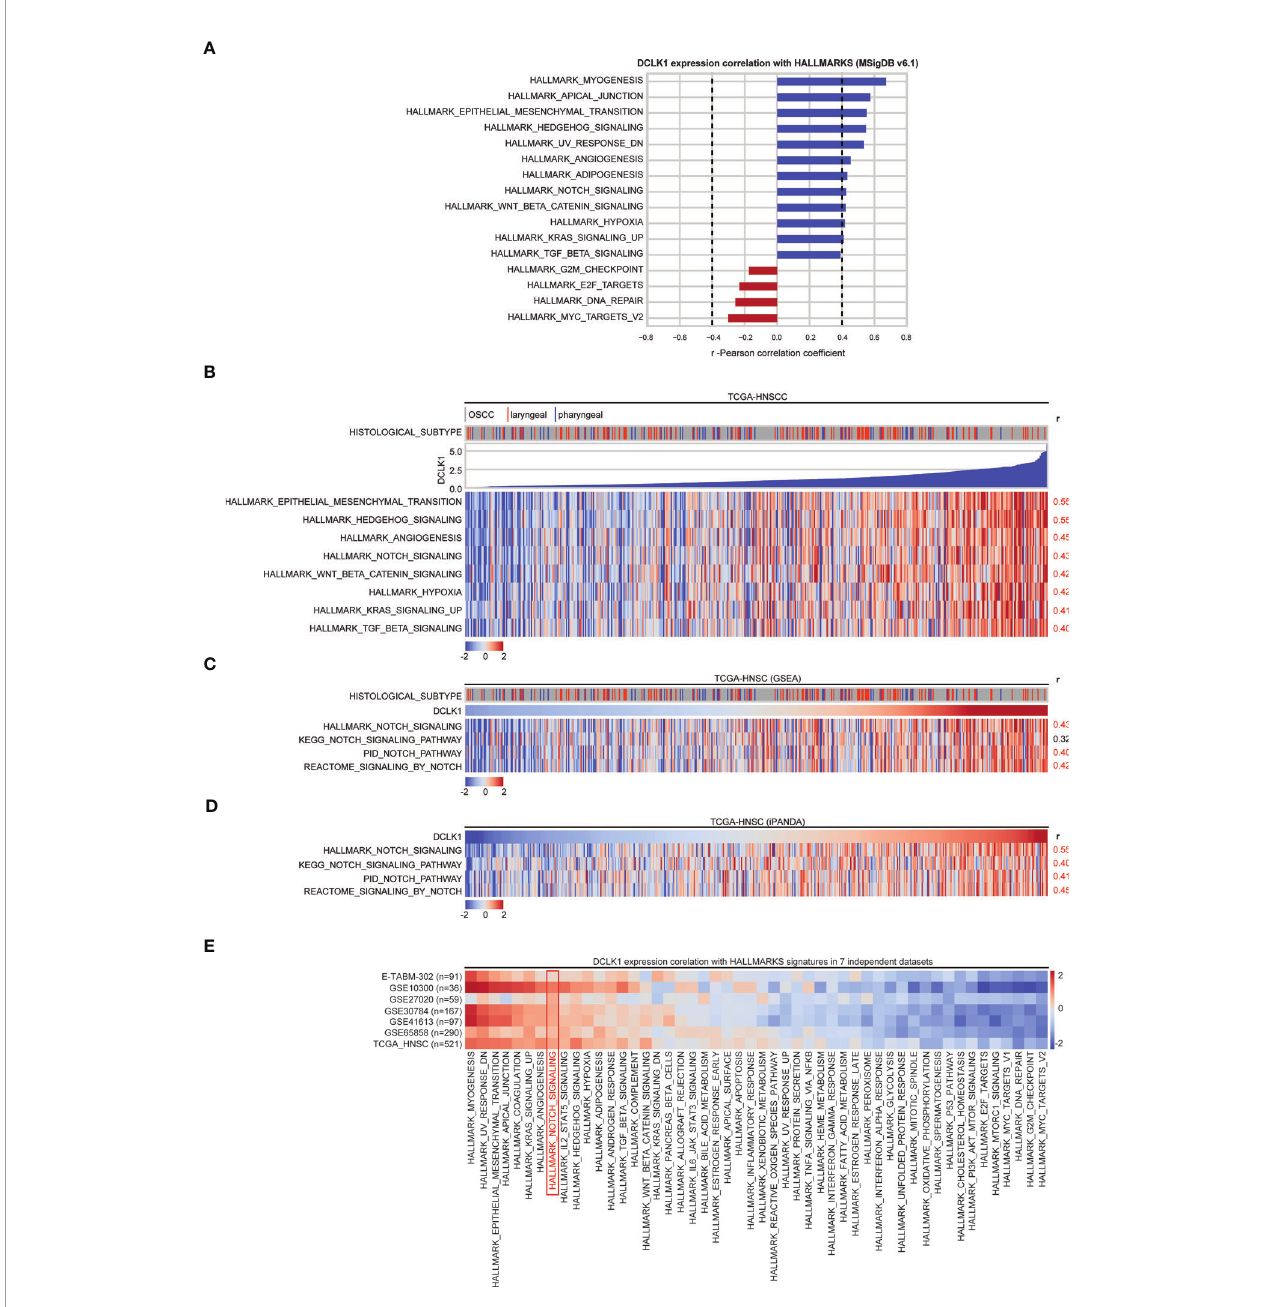
FIGURE 4 | DCLK1 correlates with NOTCH pathways in HNSCC tumors. (A) GSEA results of MSigDB Hallmark of cancer gene sets that correlate with DCLK1 mRNA expression in TCGA-HNSC transcriptomic dataset. Blue bars indicate a positive correlation with DCLK1 mRNA expression, whilst red bars indicate negative correlations. Dashed lines indicate Pearson correlation coef fi cient thresholds for inclusion of the pathways for further analysis. (B) Heatmap demonstrates Hallmark pathways that positively correlate (r > 0.4) with DCLK1 mRNA expression in TCGA-HNSC transcriptomic dataset. (C) GSEA was performed using NOTCH signaling axis genes derived from 4 pathway databases: KEGG, Reactome, PID, and Hallmark. A positive correlation between DCLK1 mRNA expression and estimated NOTCH signaling enrichment using each database is indicated by r-values on the right. (D) iPANDA software suite for analysis of intracellular signaling pathway activation based on transcriptomic data was used to estimate the level of the NOTCH signaling pathway in TCGA-HNSC dataset. NOTCH axis gene sets were derived from 4 pathway databases listed in (C) . TCGA transcriptomic data from non-tumorous samples was used as a reference after proper normalization. (E) GSEA querying of the hallmark gene sets using the transcriptomic pro fi les from TCGA-HNSC and 7 additional independent cohorts of HNSCC patients obtained from either NCBI GEO or ArrayExpress databases was performed. For each pathway, a positive correlations with DCLK1 mRNA expression are indicated in red, whilst negative correlations are shaded in